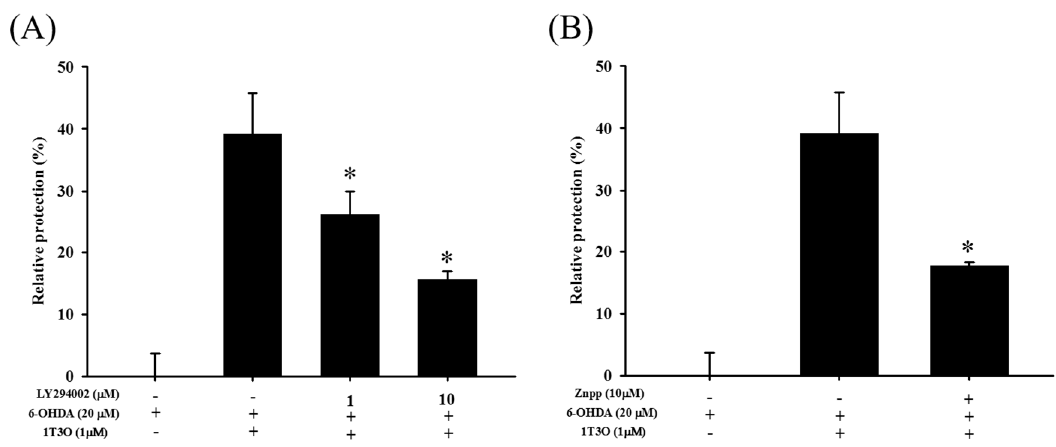
Figure 9. Effect of LY294002 and ZnPP on 6-OHDA-induced SH-SY5Y cell death inhibition by 1T3O. The alamarBlue TM reduction assay was used to study the effect of LY294002 (1, 10 μ M), a PI3K inhibitor, and Zinc Protoporphyrin (ZnPP) (10 μ M), an HO-1 inhibitor, on 1T3O inhibition of 6-OHDA-induced decrease in cell viability. Relative protection was calculated. Data are presented as mean ± SEM. * p < 0.05 vs. 6-OHDA group with 1 h 1T3O pretreatment.